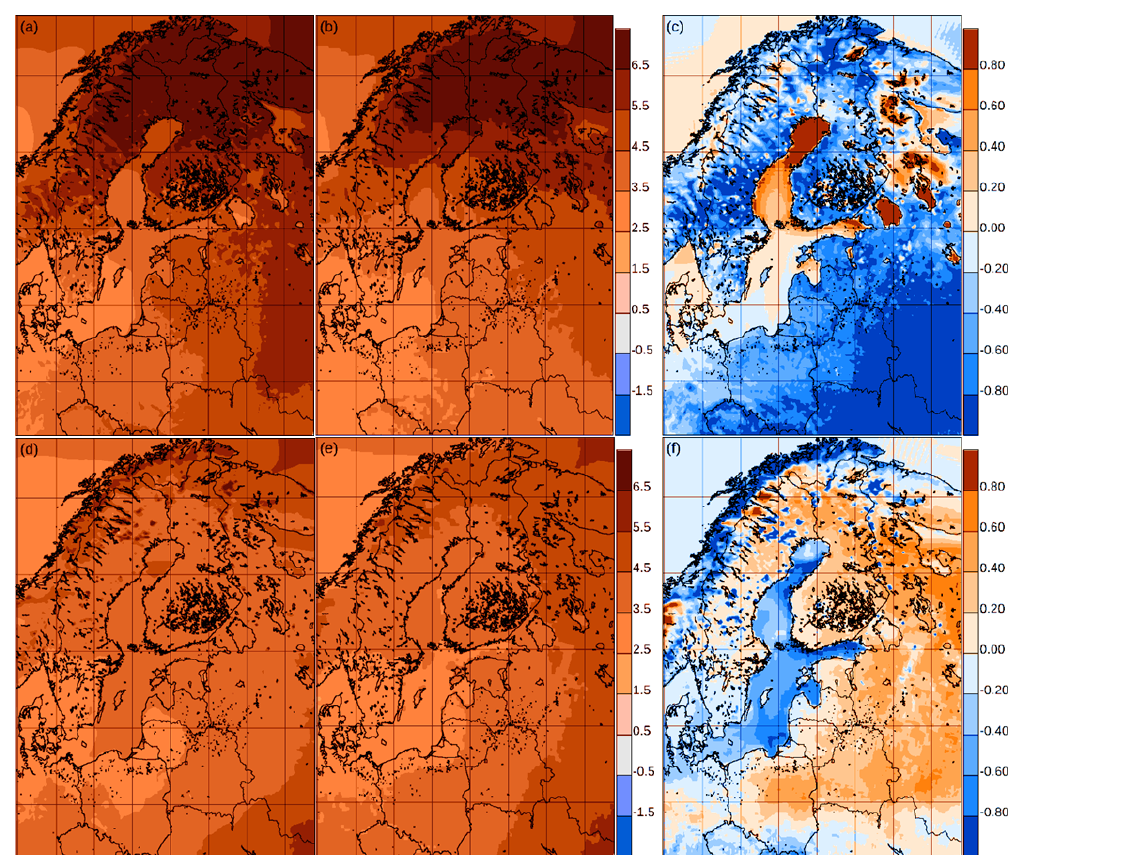
Figure 10. Temperature change between 1981–2010 and 2071–2100 for five atmosphere-only RCA4 simulations from EURO-CORDEX according to the RCP8.5 scenario (a, d) and for the coupled single-model RCA4-NEMO ensemble with the same driving GCMs (b, e) ; pointwise median values, only coloured when 75% of simulations agree on the sign of the change. Difference between the two ( c , f ; coupled minus uncoupled; ◦ C). (a–c) Winter; (d–f)